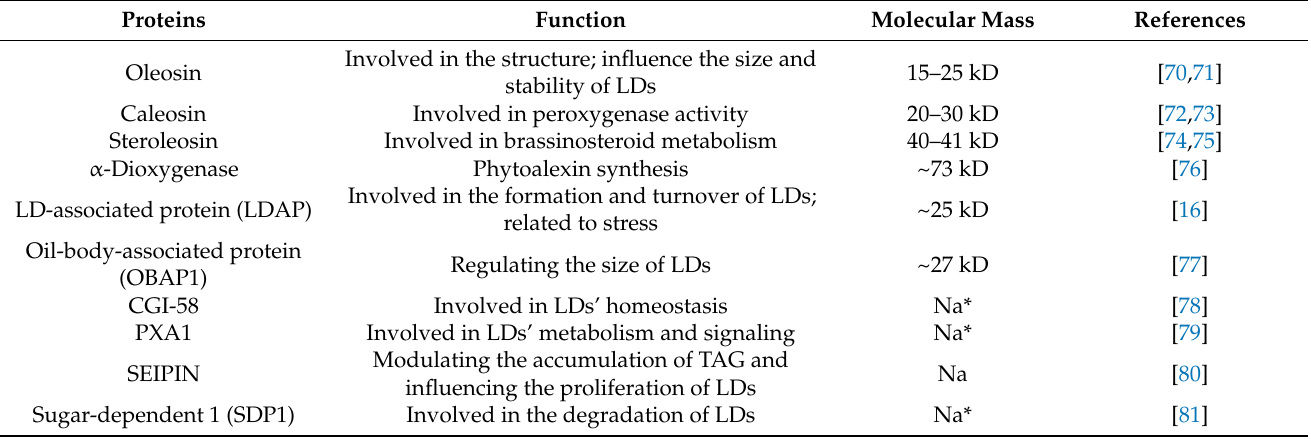
Table 3. Information on LD-associated proteins in plants and